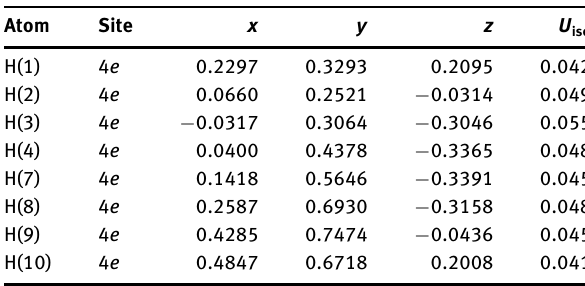
including atomic coordinates and displacement parameters.